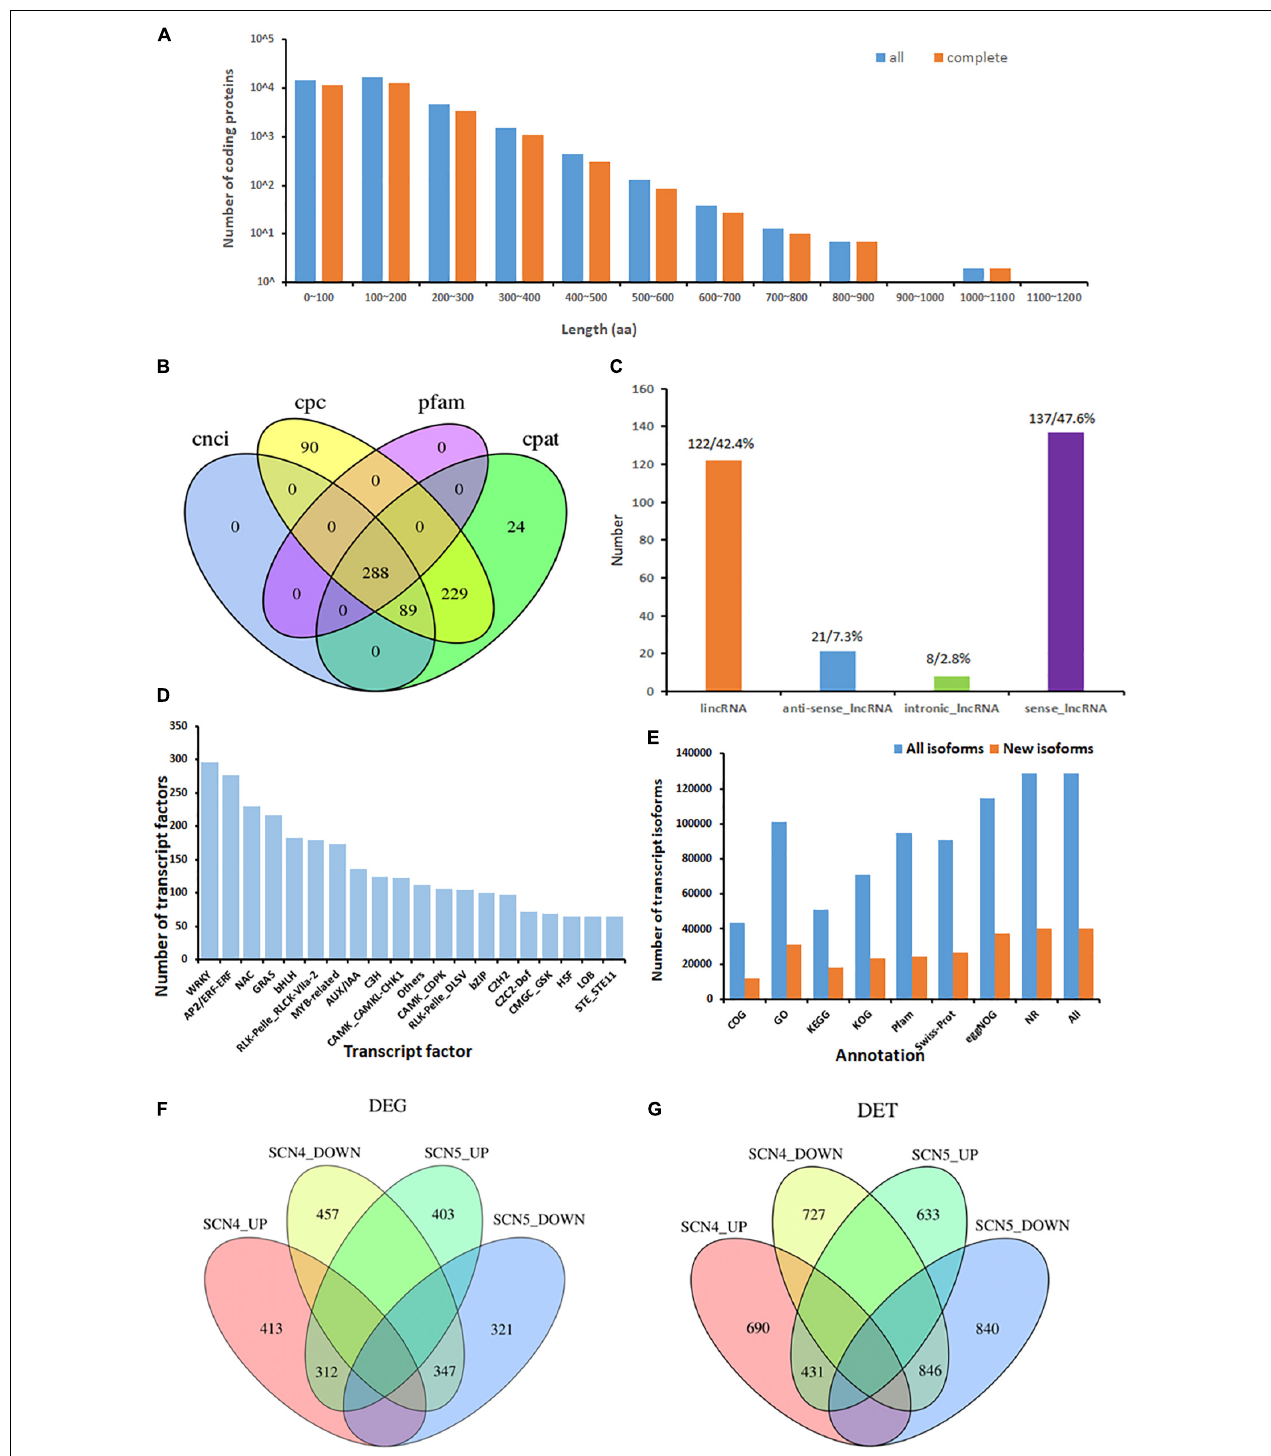
FIGURE 3 | Isoform coding sequence length, lncRNA, and transcription factors from the novel transcripts identified from 9 soybean samples, and differentially expressed genes (DEGs) or transcripts (DETs) in soybean response to soybean cyst nematode race 4 (SCN4) and race 5 (SCN5) when compared with the control (CK). (A) Length distribution of all/complete coding protein sequences predicted (unit, aa, amino acid). (B) Number of lncRNAs identified with the CPC, CNCI, CPAT, and Pfam methods. (C) Percentage of the classification of lncRNA positions annotated with the reference genomes. (D) Distribution of top 20 enriched transcription factor types. (E) Number of all and novel transcript isoforms annotated by the COG, GO, KEGG, KOG, Pfam, Swiss-Prot, eggNOG, and NR databases. (F,G) Number of upregulated and downregulated DEGs and DETs between the CK-SCN4 and CK-SCN5 treatments.